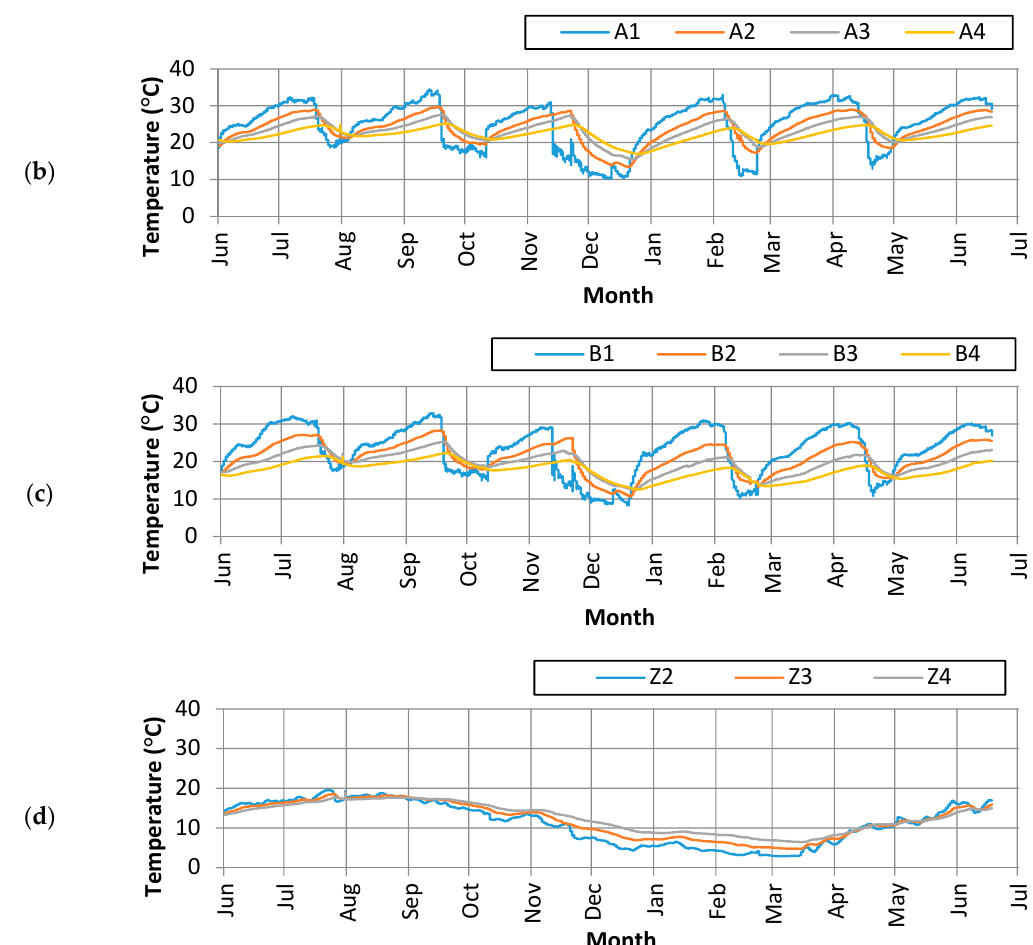
Figure 3. Curves of outdoor ( Θ e ), indoor ( Θ i ), floor ( Θ L ), and soil ( Θ G ) temperature: ( a ) outdoor air temperature ( Θ e ) and indoor air temperature ( Θ i ); ( b ) temperature at measurement points A1–A4, ( c ) temperature at measurement points B1–B4; ( d ) temperature at measurement points Z2–Z4.